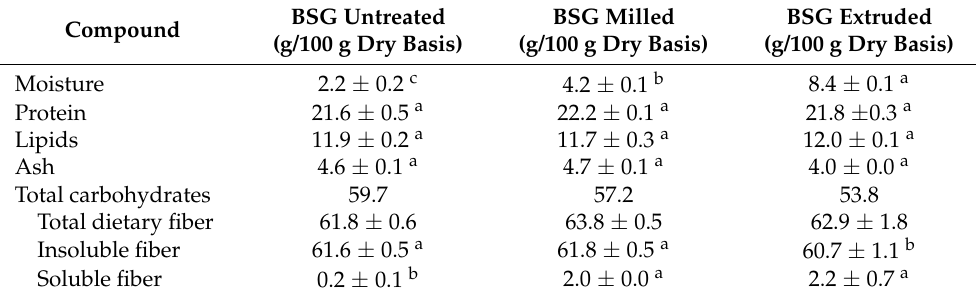
Table 3. Chemical composition of the unfermented BSG samples 1